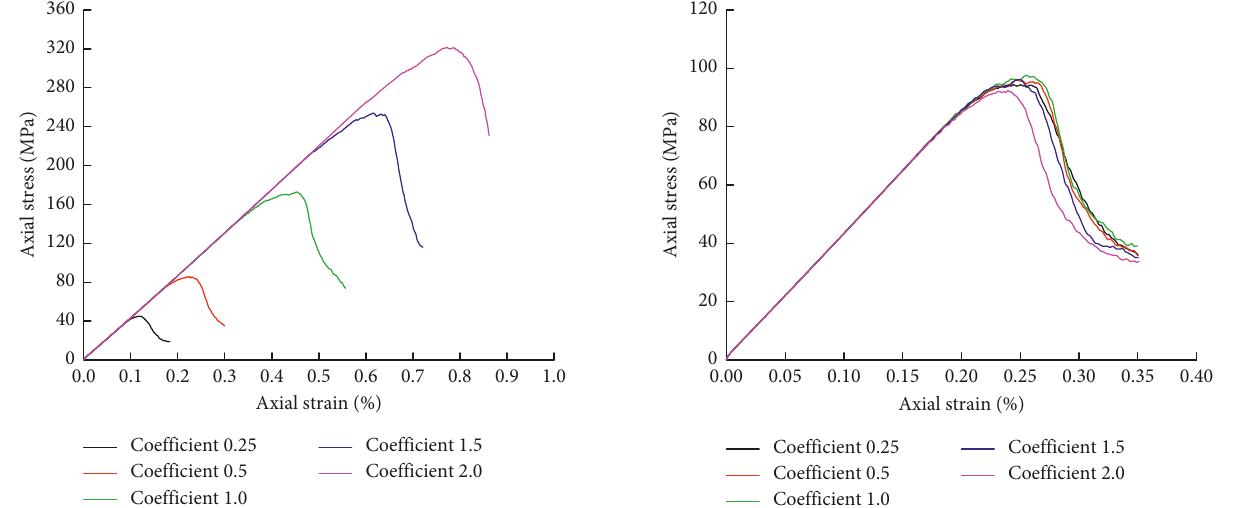
Figure 13: Axial stress-strain curves from uniaxial compression tests for the different coefficients of ξ .